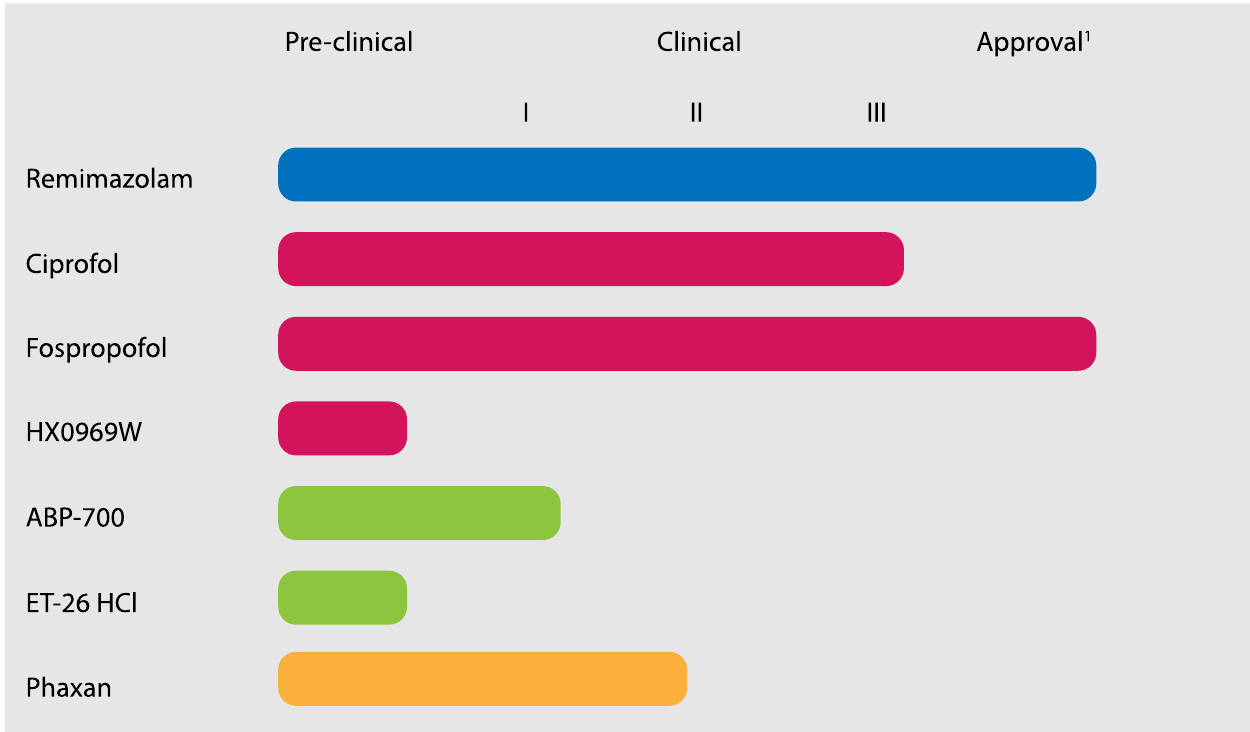
Figure 1. Overview of novel hypnotics and their current status in drug development. 1 By the Food and Drug Administration. Blue: Benzodiazepine derivative. Red: Propofol derivatives. Green: Etomidate derivatives. Orange: Steroid.